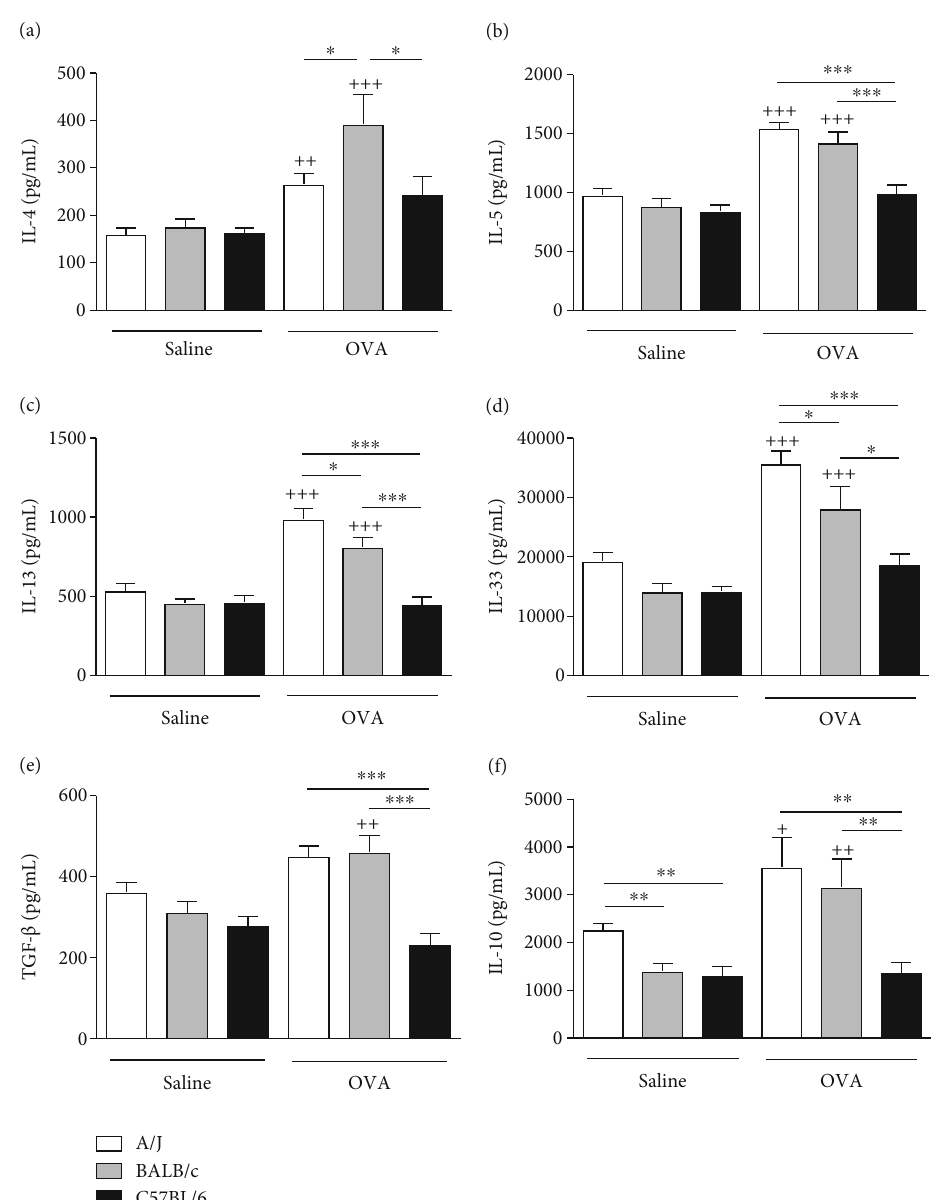
Figure 3: Production of Th2 and anti-in fl ammatory cytokines in the lung tissue of A/J, BALB/c, and C57BL/6 mice challenged with either OVA or saline. Detection of cytokines IL-4 (a), IL-5 (b), IL-13 (c), IL-33 (d), TGF- β (e), and IL-10 (f) in the lung homogenate by ELISA. Values represent mean ± SEM of 5-6 animals per group. + P < 0 : 05 as compared to saline-challenged group. ++ P < 0 : 01 and +++ P < 0 : 001 as compared to saline-challenged group. ∗ P < 0 : 05 , ∗∗ P < 0 : 01 , and ∗∗∗ P < 0 : 001 are comparisons of di ff erent OVA-challenged mouse